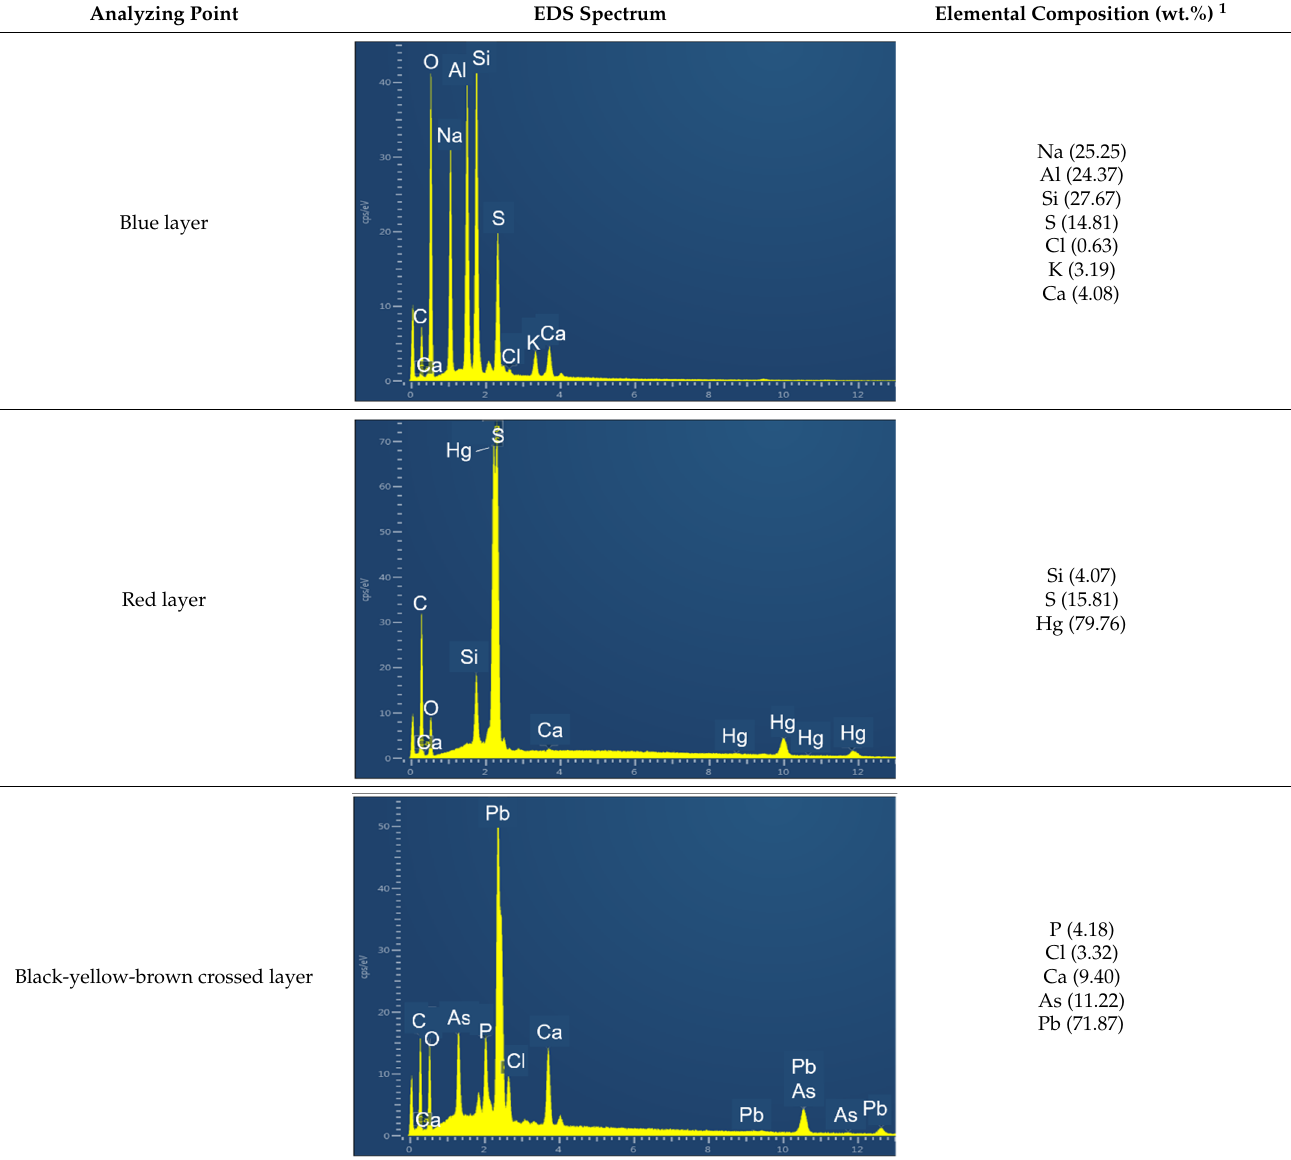
Figure 7. Overlaid elemental maps of ( a ) blue pigment, ( b ) red pigment, and ( c ) black pigment by SEM-EDS. The open crosses indicate the EDS analysis points in Table 1. Table 1. Results from SEM-EDS point analysis of the colored surface layer.